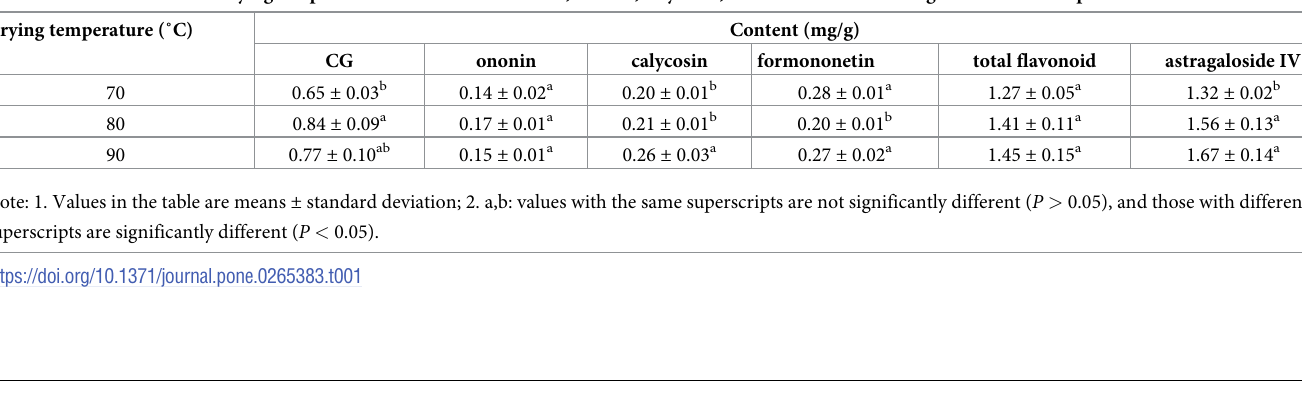
Table 1. Effects of different drying temperature on the contents of CG, ononin, calycosin, formononetin and astragaloside IV in AR pieces. Drying temperature (˚C)